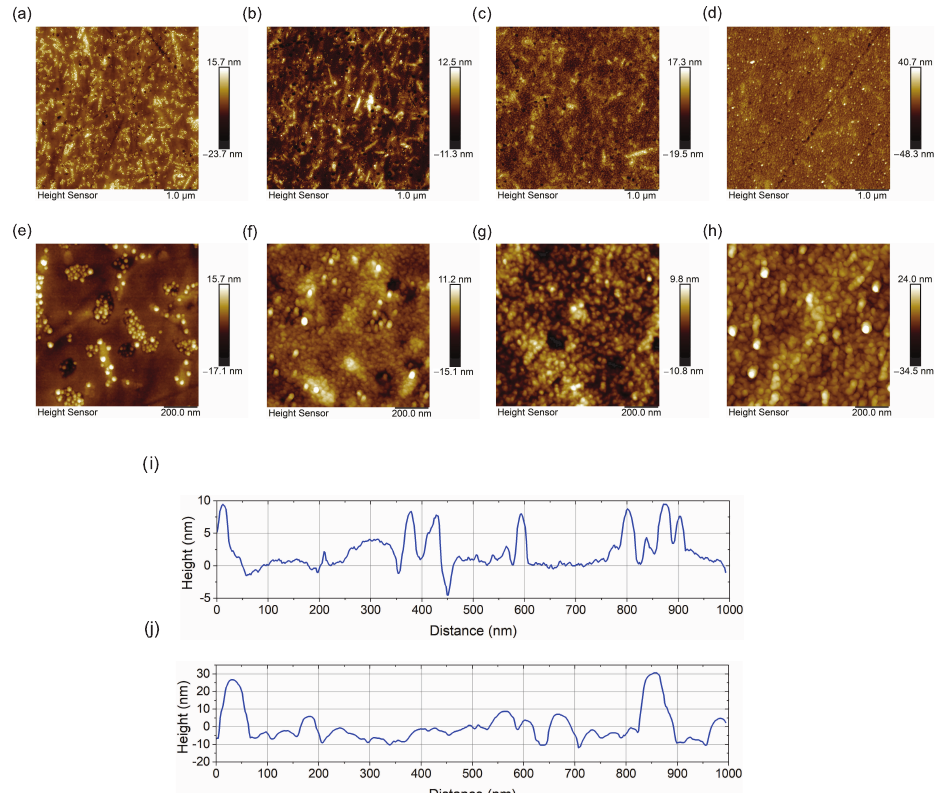
Figure 1. AFM images ( a – d ) 5 × 5 µ m 2 and ( e – h ) 1 × 1 µ m 2 of the Al 2 O 3 /(Bi–FeNi) 16 /Sitall MLF samples, where the nominal Al 2 O 3 and FeNi layer thicknesses are 2.1 and 1.8nm and the nominal Bi layer thicknesses are 0.6, 1.4, 2.0, and 2.5nm, respectively. The estimated surface RMS roughness values are in ( a – d ), 3.6, 3.0, 3.1, and 5.2nm, and in ( e – h ), 3.2, 2.6, 2.7, and 5.3nm, respectively. ( i , j ) The typical height profiles for the MLF samples with the nominal Bi layer thicknesses of 0.6 and 2.5nm,